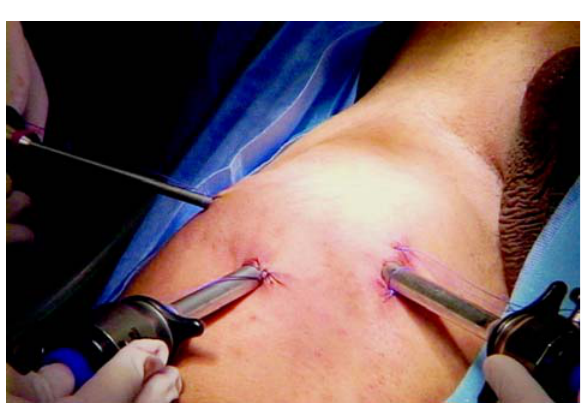
lymphadenectomy. The work space was almost all filled up by the diffusion of gas.